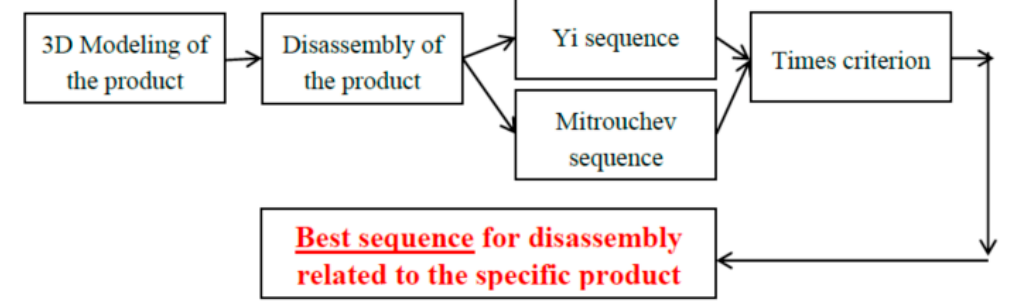
Figure 3. Optimal sequence search algorithm.